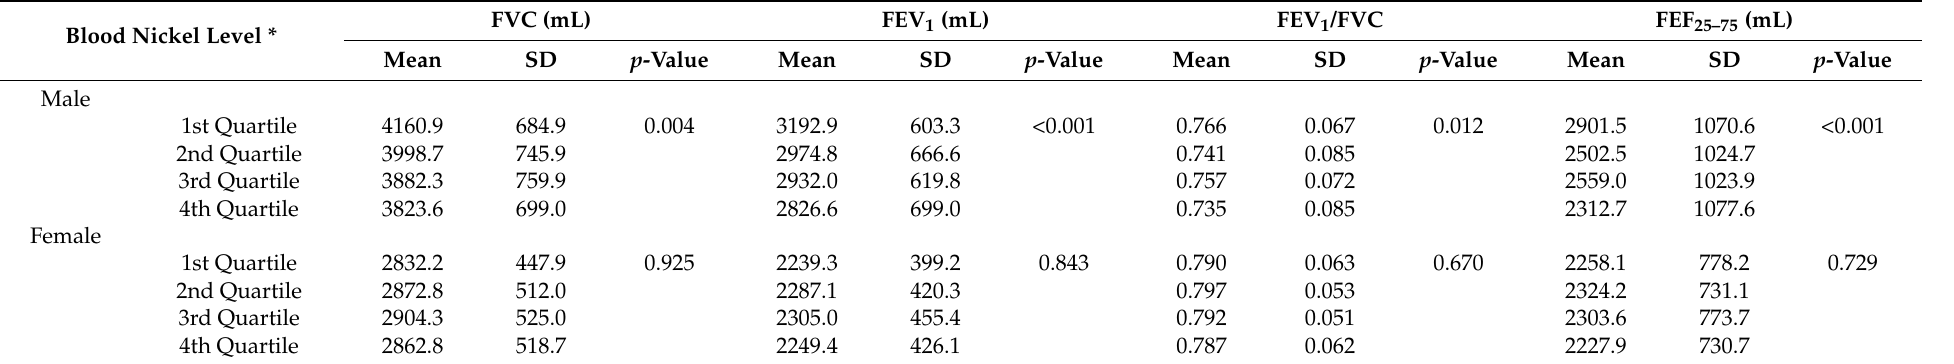
Table 2. Pulmonary function profiles according to blood nickel level quartiles and